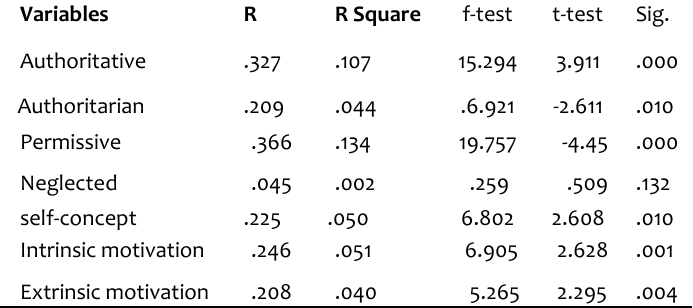
Table 5: Leaner Regression statistics of predictor variables on students’ academic achievement